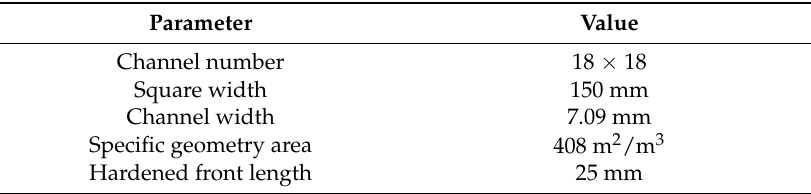
Table 1. Catalyst parameters.